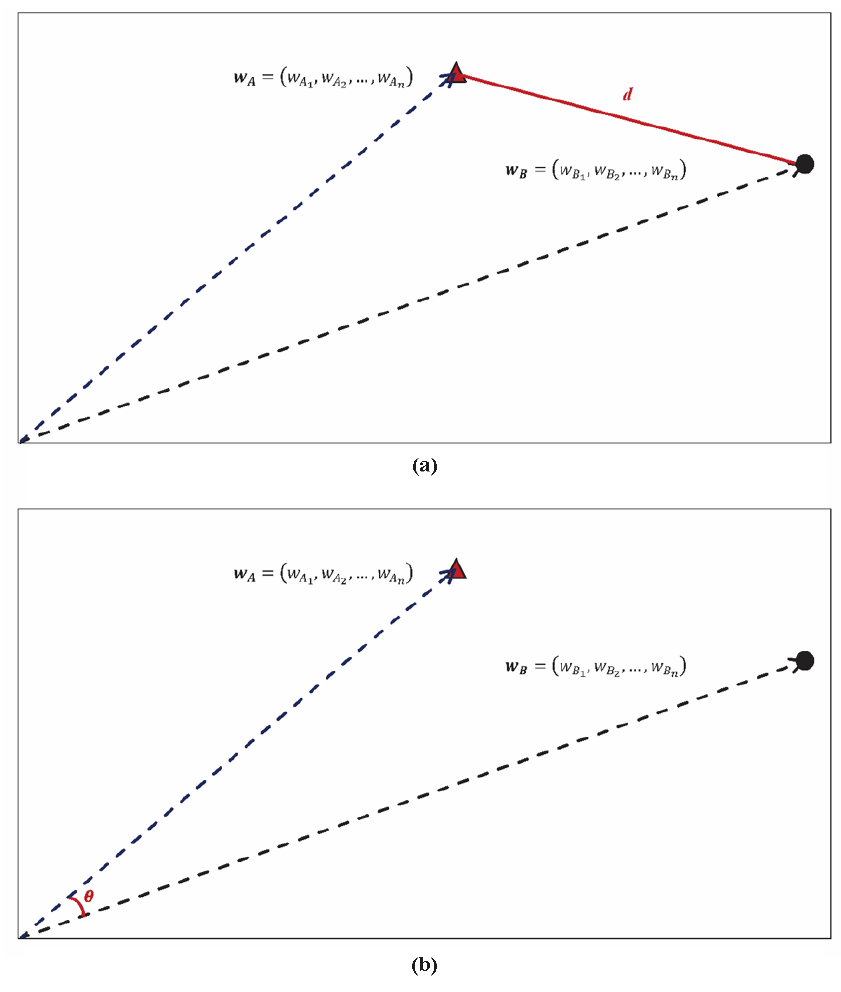
Figure 1. Norm and inner product methods to measure similarity between two vectors. ( a ) distance measured by the norm; ( b ) distance measured by the inner product.